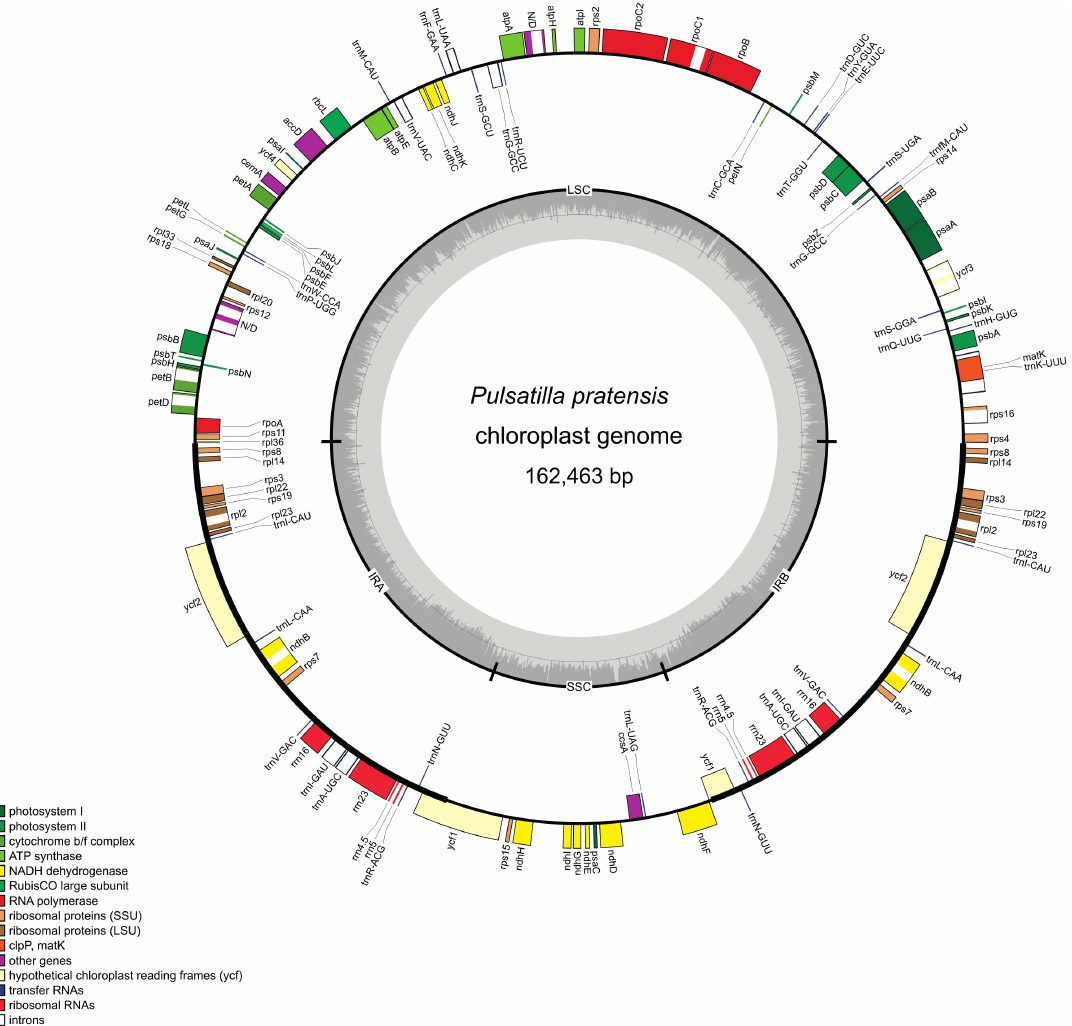
Figure 1. Gene map of the Pulsatilla pratensis plastid genome. Genes shown outside the outer circle are transcribed clockwise, and genes inside the outer circle are transcribed counterclockwise. Genes belonging to different functional groups are color coded. The dashed area in the inner circle indicates the guanine-cytosine (GC) content of the plastid genome. 2.2. Variation in the Plastid Genome Structure of the Family